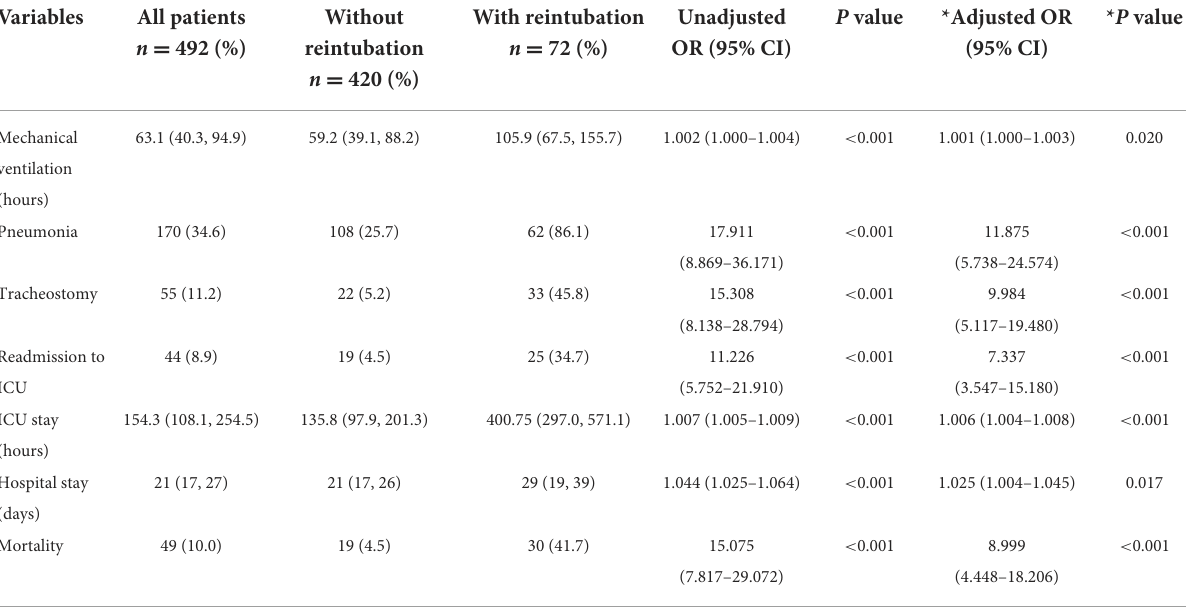
TABLE 4 In-hospital clinical outcomes in patients with and without reintubation after AADS.